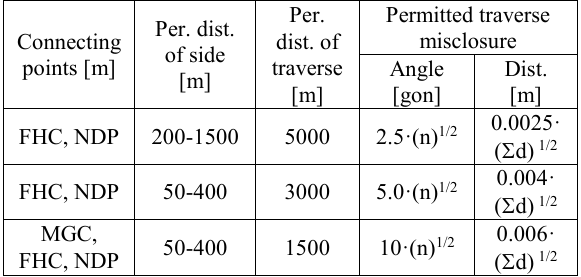
Table 1. Parameters and permitted deviations of